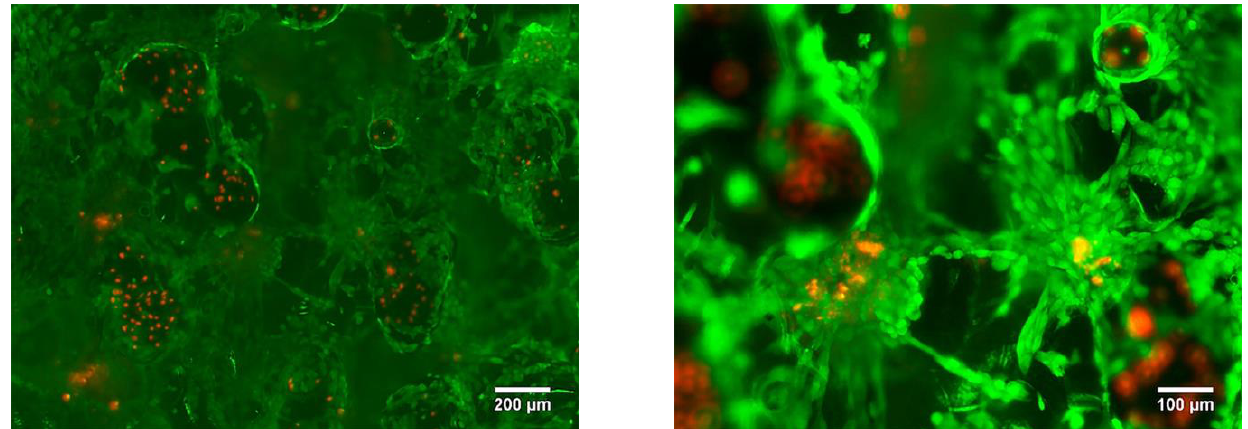
Figure 19. Porous Ti-45wt.% Nb sample LIVE/DEAD stained with Calcein AM/PI after 3 days of incubation. The cell attachment was high and resulted in adherence to most of the samples’ pointed tips and valleys without detaching. Homogeneous distribution of the cells in the bulk of the sample was not achieved solely by the cell migration, but also by the seeding method. Due to the open porosity of the LPBF sample (Figure 14), the cells that were transferred in the volume of medium slowly passed through the pores, filling the avail- able volume. After three days of culture, the fluorescence images showed a similar cell density between fully dense and porous substrates. After seven days of incubation, the MG63 cells homogenously covered the whole visible surface of the porous LPBF sample, reaching 95% surface confluency. We suppose that the surface roughness and open porosity can support the cell adhesion and prolifer- ation by imitating native extracellular matrix properties. Furthermore, with a longer culture times, cells were able to proliferate, showing an increased cell density over the entire surface. Indeed, on day seven the MG63 cells were covering the entire porous structure (Figure 20), even filling the pores attaching to pore walls and arriving at the edge of the samples, similarly to the findings presented in the paper by A. Civantos et al. [17]. Figure 20. Porous Ti-Nb sample LIVE/DEAD stained with Calcein AM/PI after 7 days of incubation. The other group of dense LPBF samples was also found to be non-cytotoxic. The rough surface of the sample allows cells to more easily adhere, resulting in a confluency coverage on the surface of close to 100% after seven days of incubation (Figure 21).